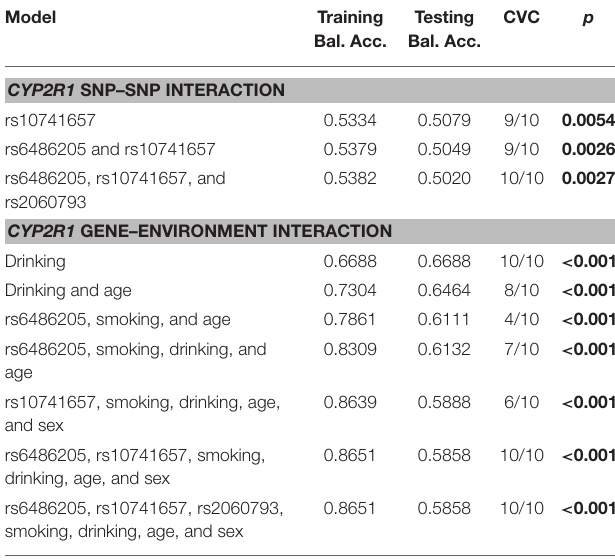
FIGURE 1 | Haplotype block map for three SNPs in CYP2R1 . A block was comprised of rs10741657 and rs2060793. Number in diamond represents D ′ -value.